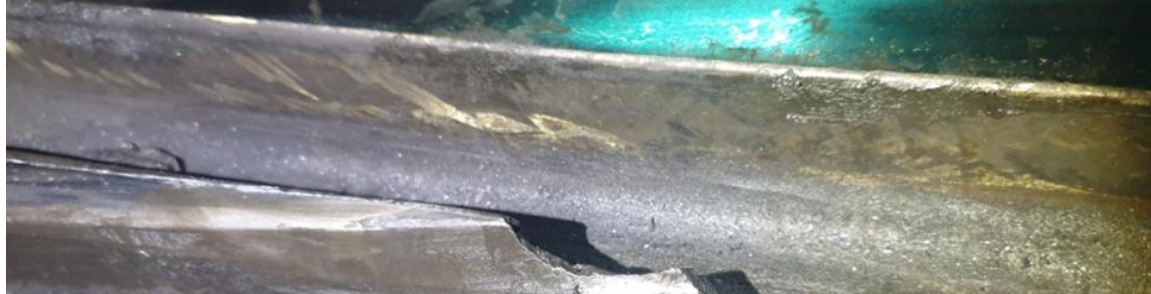
Figure 6. Squat. Figure 6. Squat.